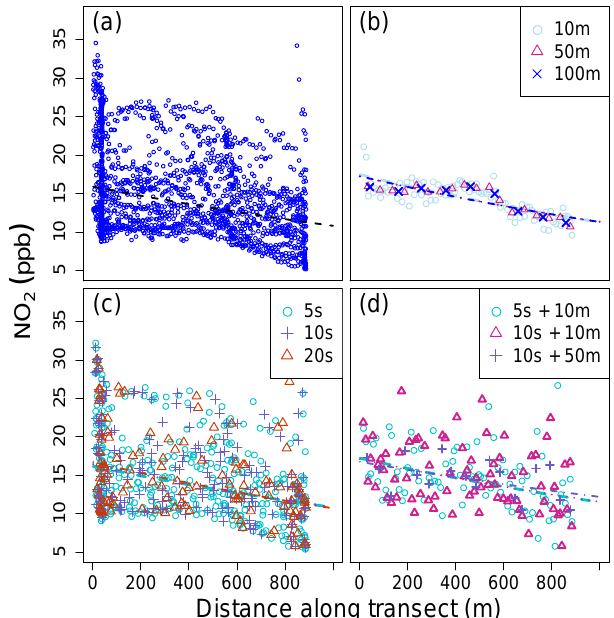
Figure 8. Comparison of the effect of temporal and spatial smooth- ing on NO 2 measurements collected on the 900m transect of route B, shown in Fig. 3, by distance from the highway: (a) raw data; (b) data after spatial smoothing by calculating mean concentrations by 10, 50, and 100m route segments; (c) data after temporal smooth- ing by calculating discrete 5, 10, and 20s averages; and (d) data after combination of temporal and spatial smoothing. The model NO 2 = m × log ( distance ) + b was fit for each smoothing case. The regression lines are plotted with the respective data and the color corresponds with the points